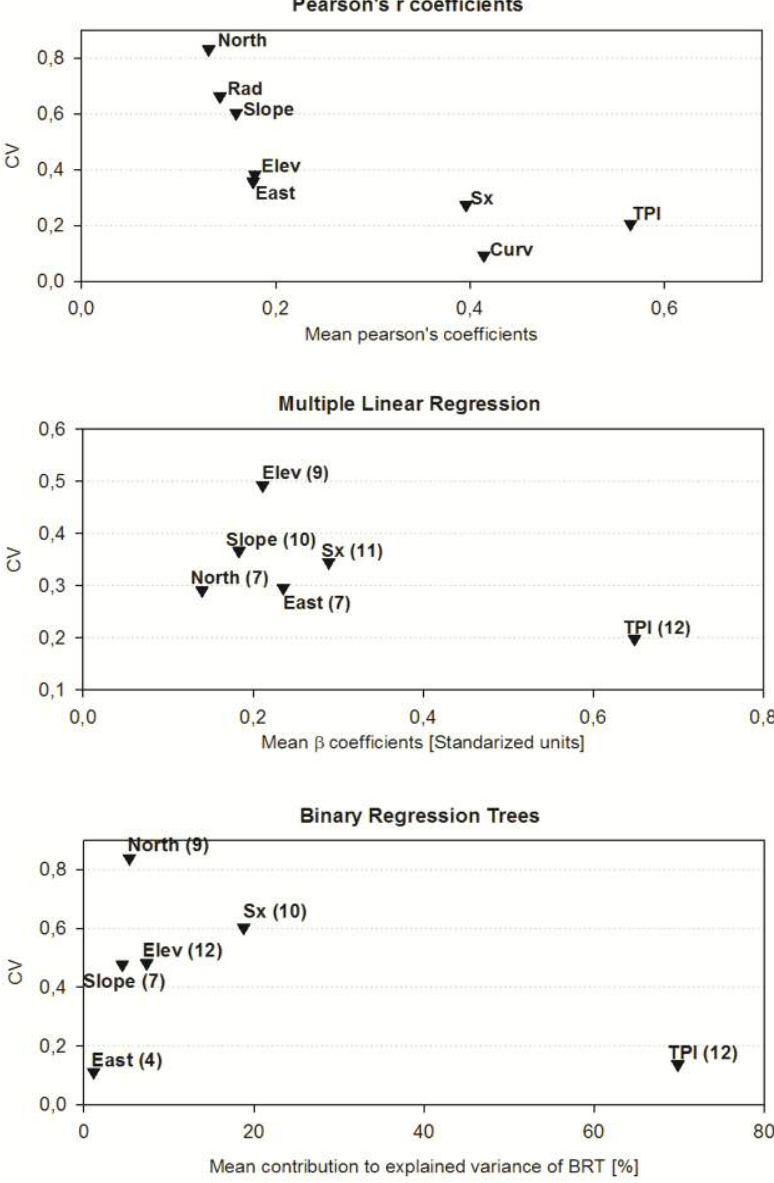
Figure 7. Mean contribution of topographic variables to models and Pearsons’ r coefficients vs. the coefficients of variation for all considered surveys. Upper panel shows Pearson’s r coefficients; middle panel shows beta coefficients of the multiple linear regression; and the bottom panel shows the contribution to the explained variance to the binary regression trees. Each graph point is accompanied with its variable, and in the case of MLR and BRT, in brackets the number of days in which each variable was included in models.